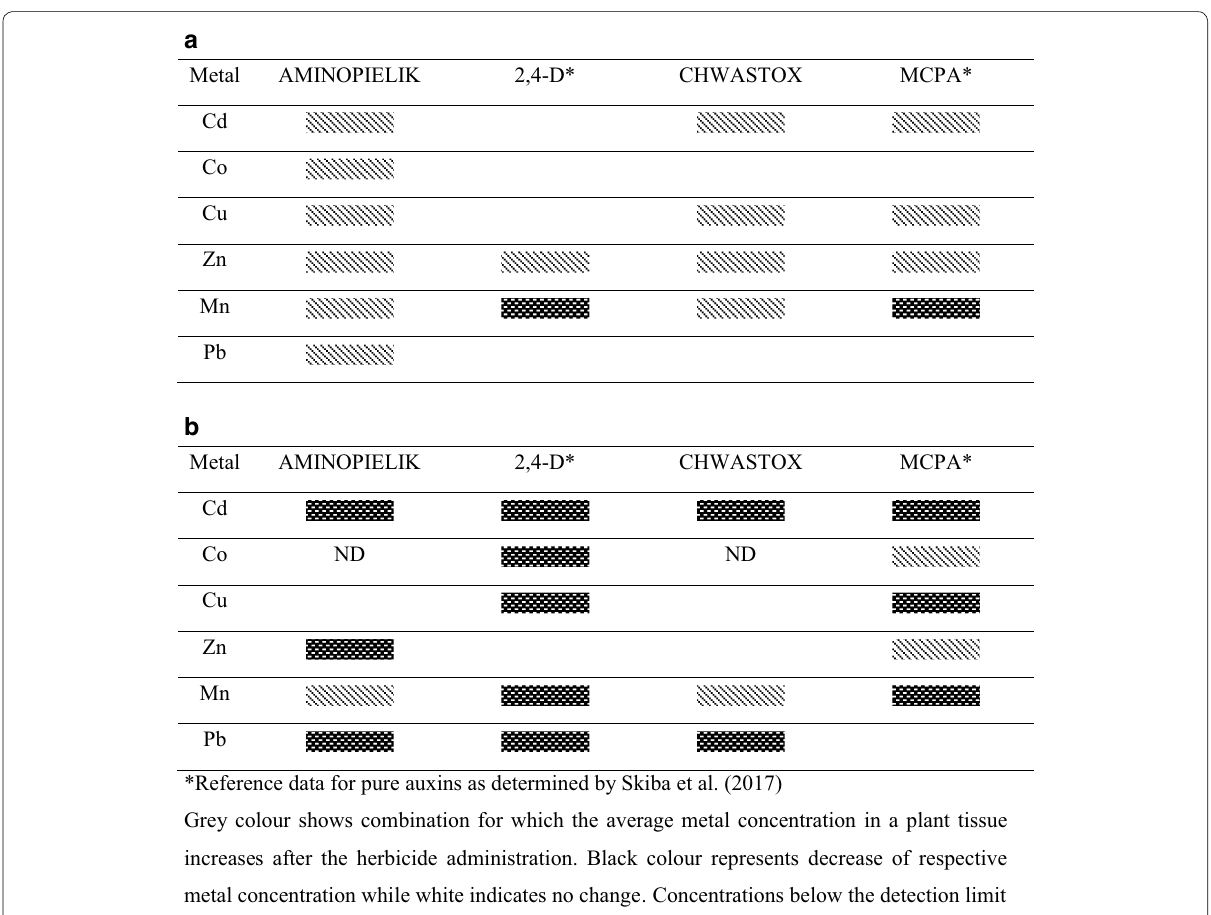
Fig. 1 The influence of Aminopielik and Chwastox on heavy metals accumulation in wheat roots ( a ) and shoots ( b ). Asterisk reference data for pure auxins as determined by Skiba et al. [13]. Grey colour shows combination for which the average metal concentration in a plant tissue increases after the herbicide administration. Black colour represents decrease of respective metal concentration while white indicates no change. Concentrations below the detection limit are indicated by the acronym ND. The 0.95 probability level was applied for ANOVA